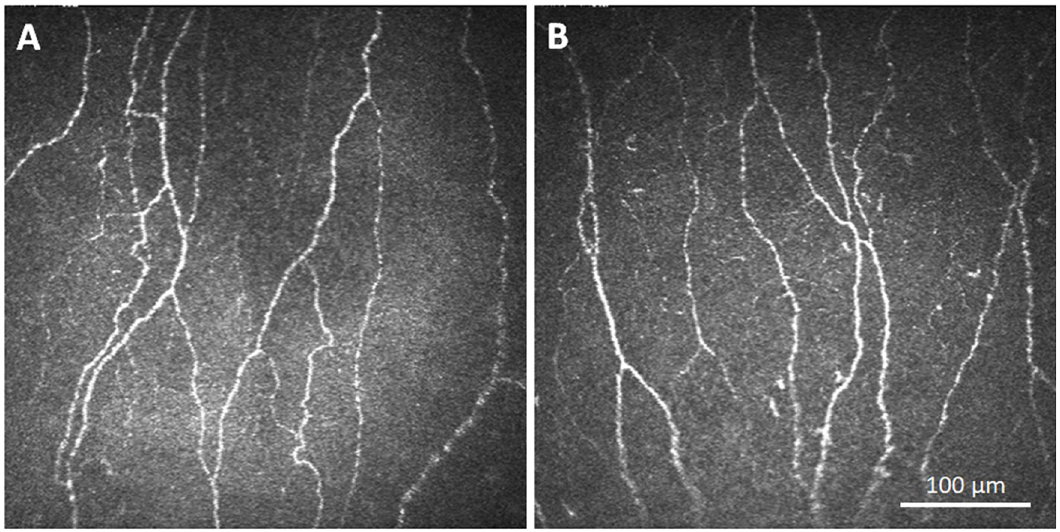
Table 4. Representative images of the visible cell layers and region of measurement are shown